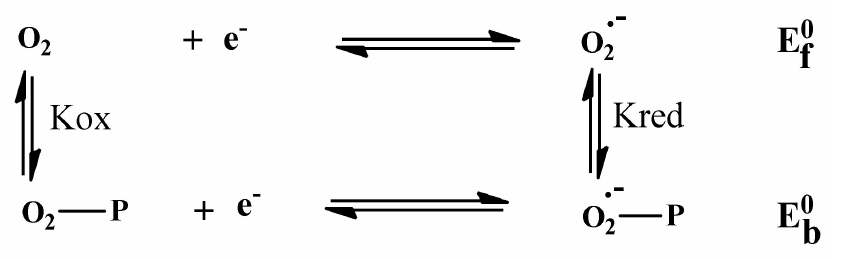
Figure 14. Redox process of the free and E-bound O 2/ O 2.- redox couple, where E represents E 2 or E 3